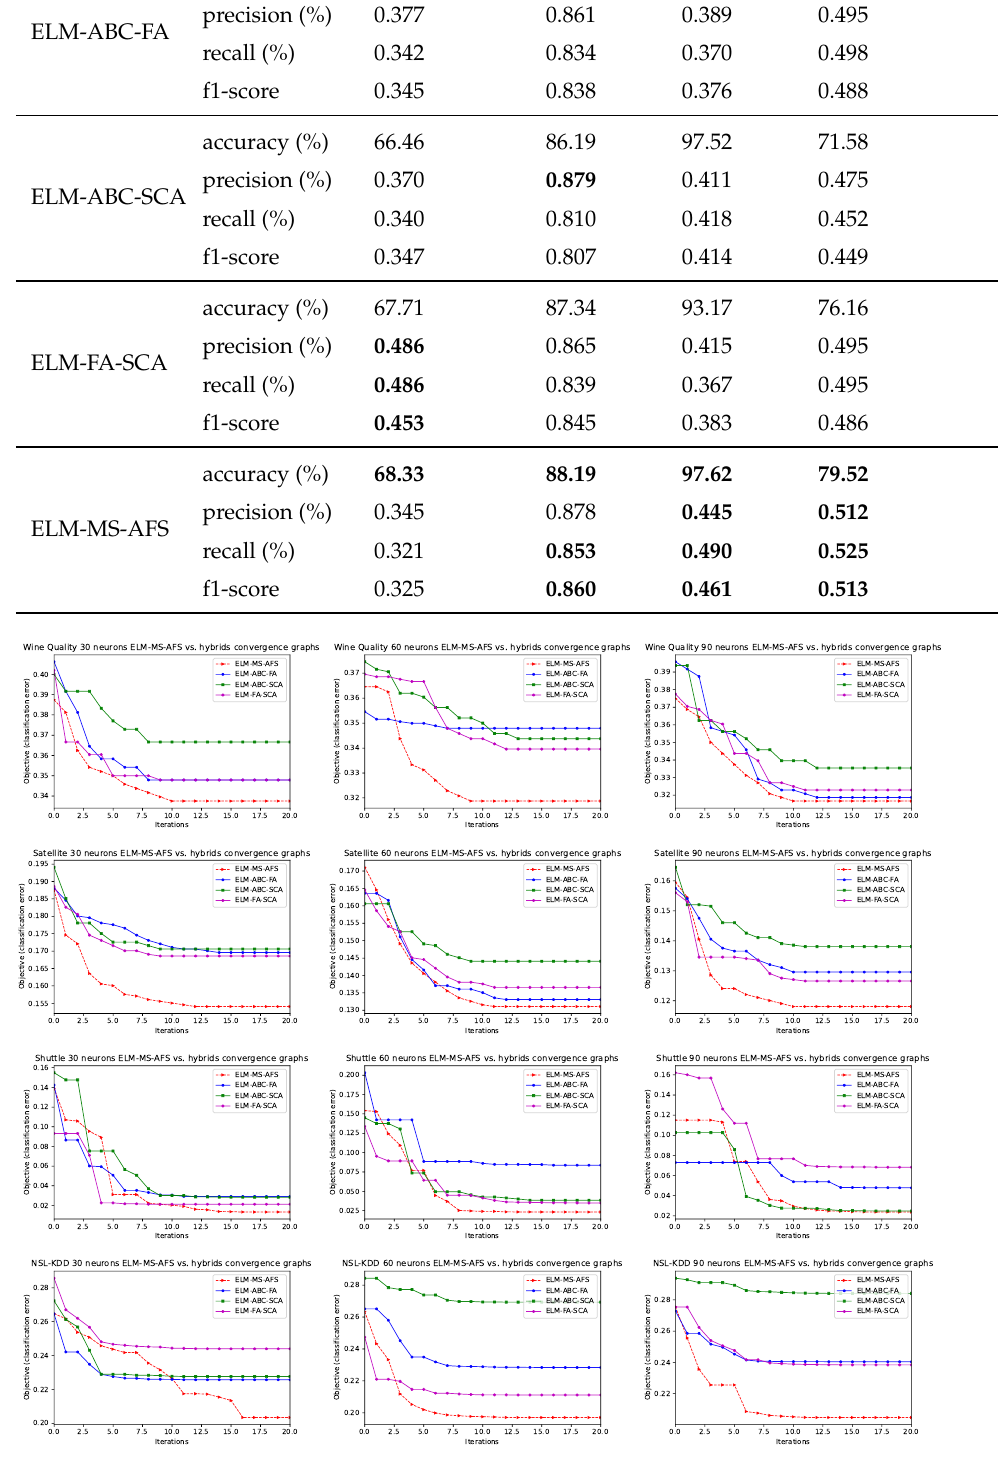
Figure 7. Graphs for convergence speed evaluation on four observed datasets for 30, 60, and 90 neurons, for the proposed ELM-MS-AFS vs. other hybrid